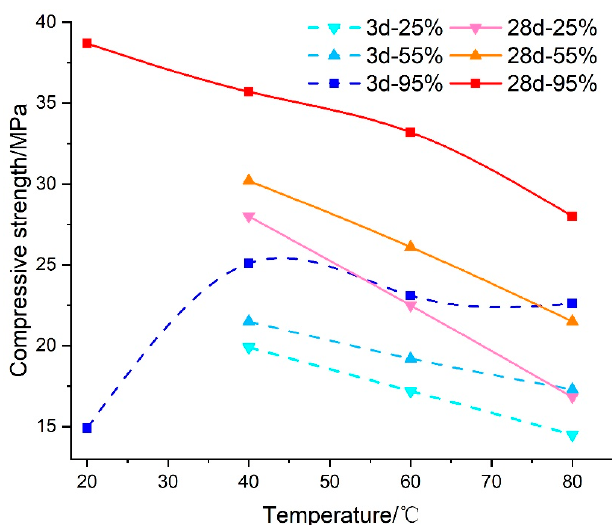
Figure 4. The impact of temperature on the compressive strength of grouting material.